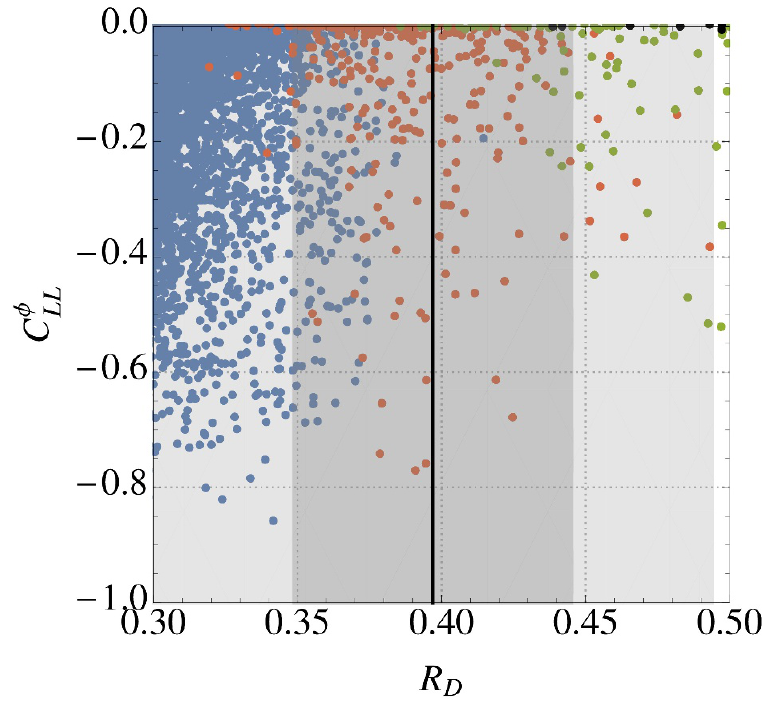
Figure 14. A projection of the random points subject to scan II onto the R colors corresponding to (cid:27) -regions of the (cid:12)t to R 1, 2, 3 or > 3 (cid:27) region for R measurement, and the grey bands correspond to the 1 and 2 (cid:27) regions. Parameter choices leading to the required large, negative value for C (cid:30) R D (cid:3) . A combined explanation of R This represents a signi(cid:12)cant improvement on the